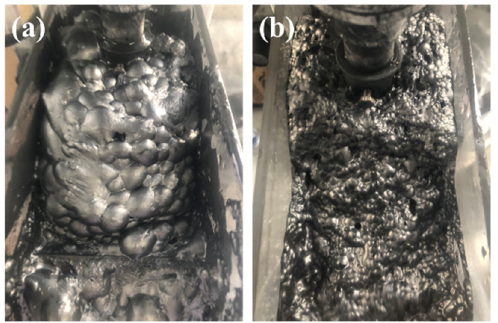
Figure 9. The foam structure of the solution in the presence of ( a ) KCl, ( b ) MgCl 2 , and ( c ) AlCl 3 at 0.10 mol/L. Figure 10. The top-view of the flotation foam in the ( a )absence and ( b )presence of MgCl 2 at 0.2 mol/L.